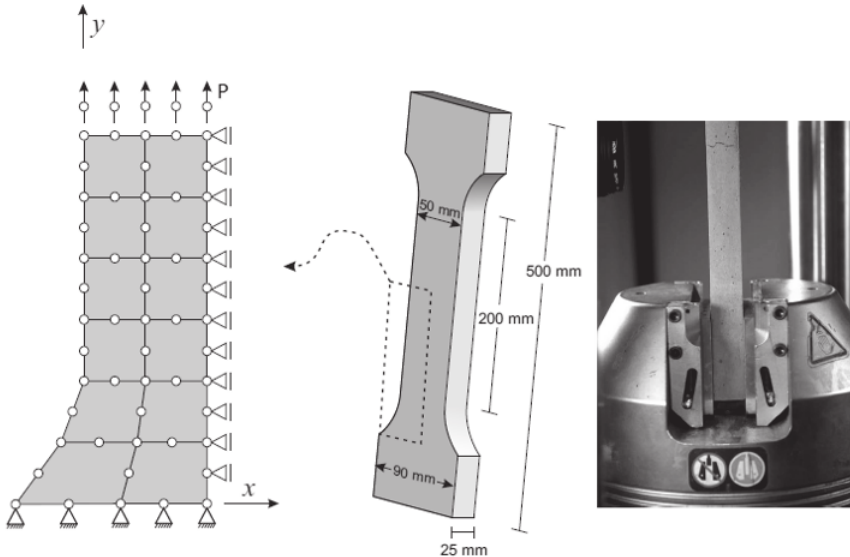
Dogbone-shaped panel – Finite element mesh, geometry and image of supports used during the test performed by PEREIRA et al [23]. Adapted from PEREIRA et al.